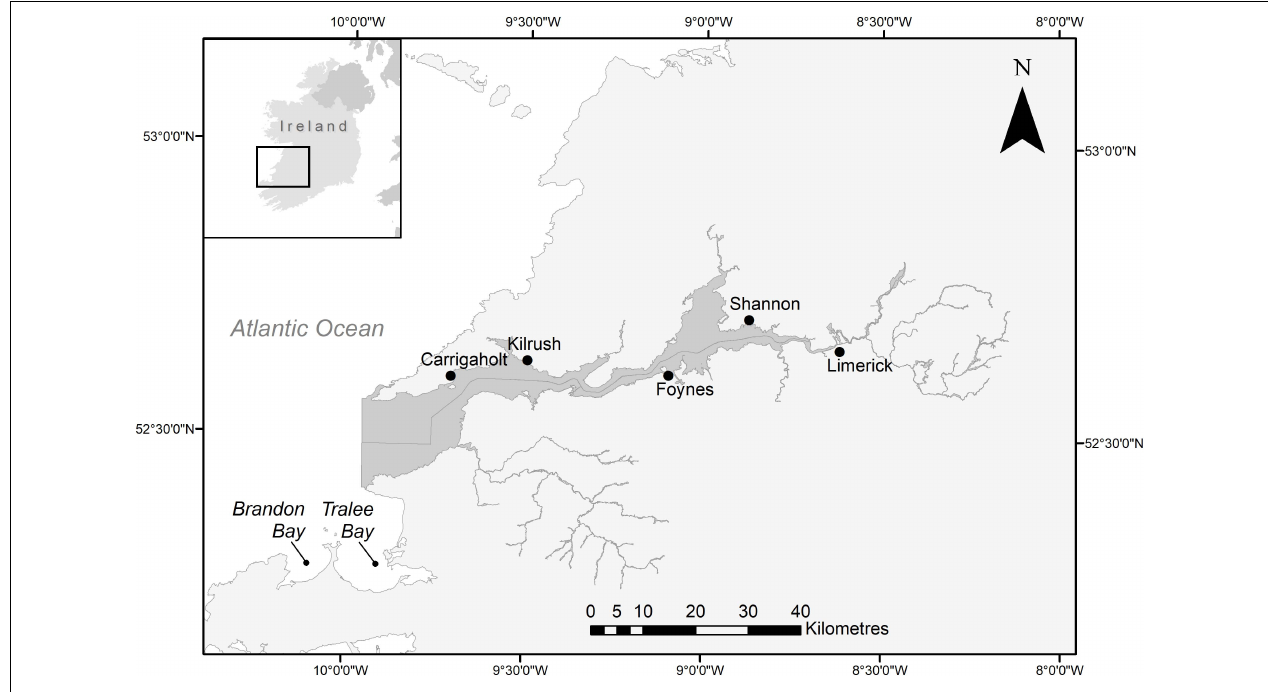
FIGURE 1 | Map of the lower river shannon special area of conservation (dark grey). The line dividing the estuary horizontally marks the county border between Co. Clare (North) and Co. Kerry (South). Tralee- and Brandon Bays are indicated to the southwest. Geospatial Data Sources : Ireland Ordnance Survey (Settlements Data), DIVA-GIS (Country Boundary Data), National Parks and Wildlife Service (SAC Boundary Data).